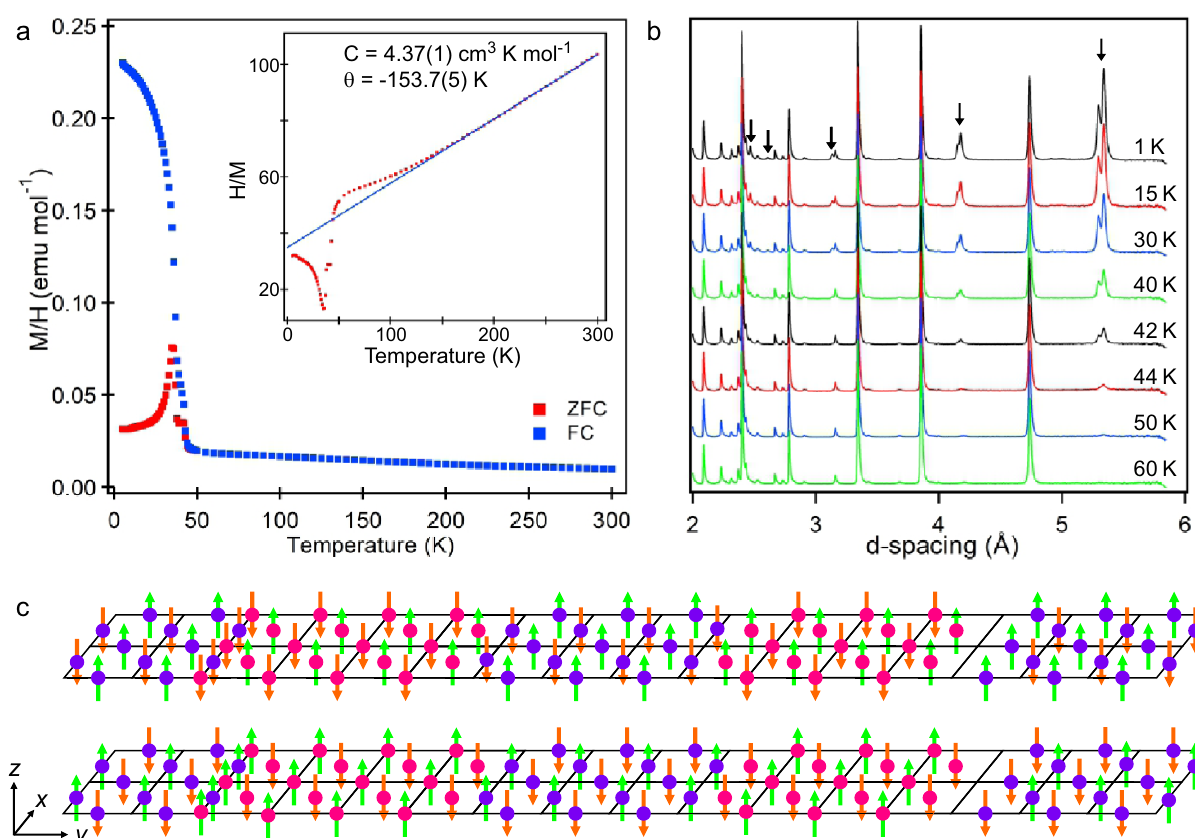
Fig. 3 Magnetic behaviour of MnSrTa 2 O 7. a Zero- fi eld-cooled and fi eld-cooled magnetisation data collected from MnSrTa 2 O 7 , the inset shows the fi t to the Curie – Weiss law in the range 150 < T /K < 300. b NPD data collected at indicated temperatures from MnSrTa 2 O 7 . Arrows mark magnetic scattering peaks. c The re fi ned magnetic structure of MnSrTa 2 O 7 . Pink and purple spheres represent Mn cations using the colour scheme from Fig. 2, green and orange arrows indicate the direction of the ordered magnetic